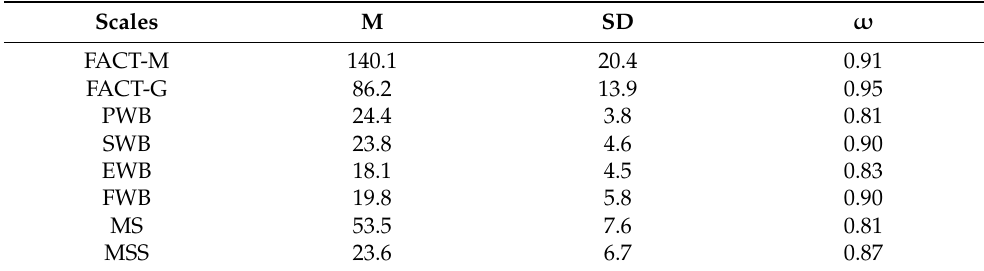
Table 2. Mean scale scores (M), standard deviations (SD), and reliability ( ω ) of the total FACT-M scale and the subscales FACT-General (FACT-G), Physical well-being (PWB), Social well-being (SWB), Emotional well-being (EWB), Functional well-being (FWB), Melanoma scale (MS), and Melanoma surgical scale (MSS). Scales M SD ω FACT-M 140.1